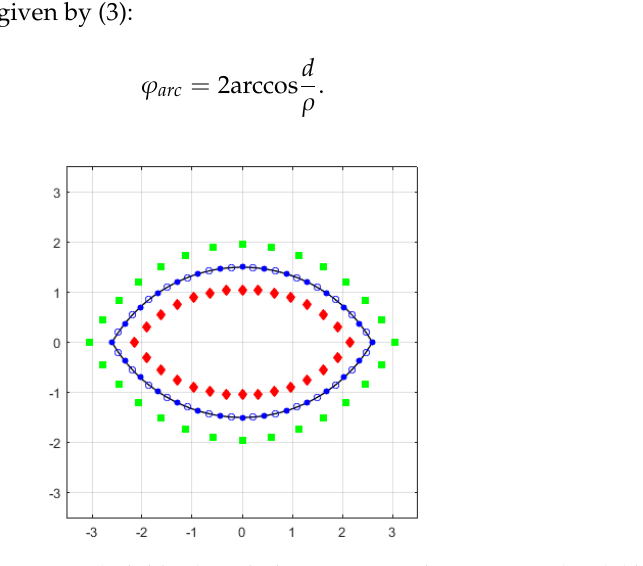
Figure 1. Geometry of the scatterer (solid line), including inner auxiliary sources (ASs) (diamonds) and outer auxiliary sources (ASs) (squares). The dots stand for collocation points (CPs) and circles for midpoints (MPs).